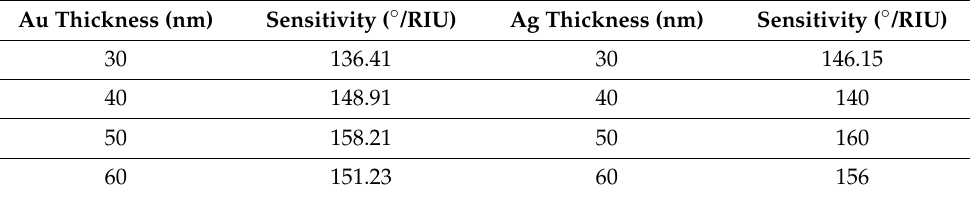
Figure 2. Sensitivity for the Ag layer thickness from 30 nm to 60 nm. Table 2. Au and Ag thickness comparison for sensitivity of the proposed structure.